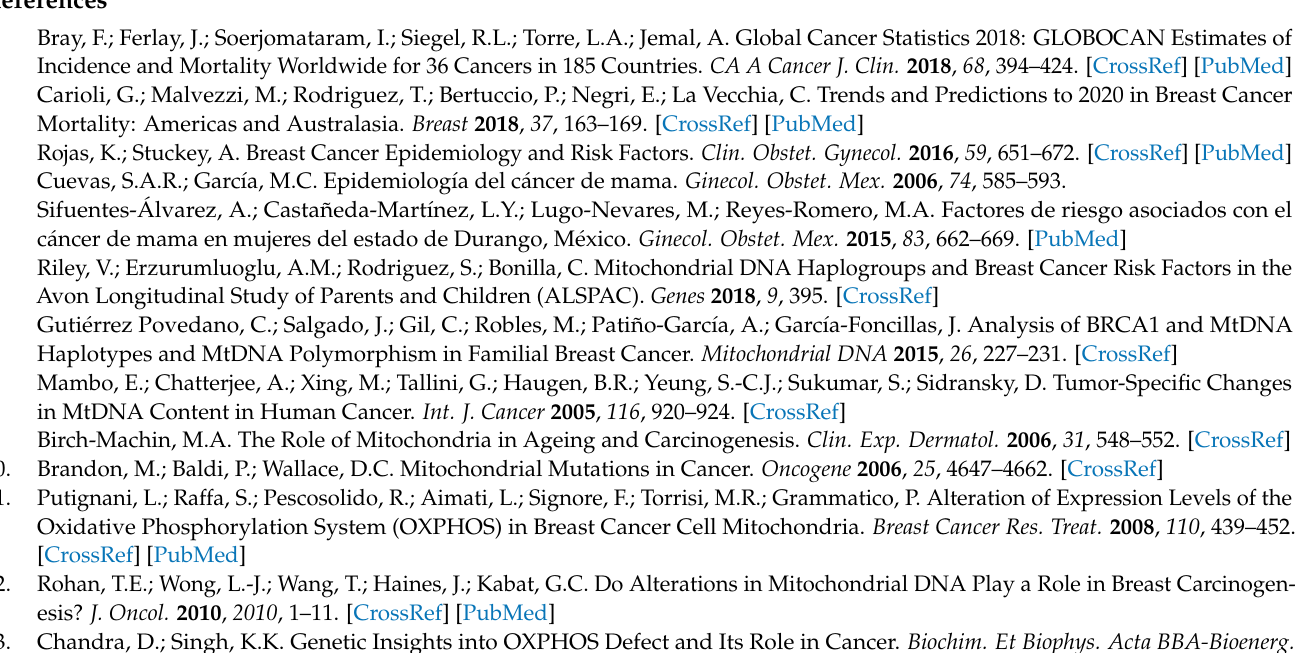
Figure S6: Positions 315 and 309–310 in mtDNA shows common hallmark features found in breast cancer tissue and controls. Image from UCSC Genome Browser [42]; Table S1: Origin and references of mtDNA sequences associated with breast cancer and controls used for the analysis; Table S2: Comparative summary of macrohaplogroups’ distribution obtained from complete and partial mito- chondrial sequences from patients diagnosed with breast cancer; Table S3: Comparative summary of the distribution of possible phantom polymorphisms in complete mtDNA sequences with breast cancer diagnosis. Table S4: Summary of the heteroplasmic in mtDNA sequences by position in cases diagnosed with breast cancer; Table S5: Summary of the heteroplasmic polymorphisms detected by sequence and not related with haplotyping in the mtDNA sequences of cases diagnosed with breast cancer and